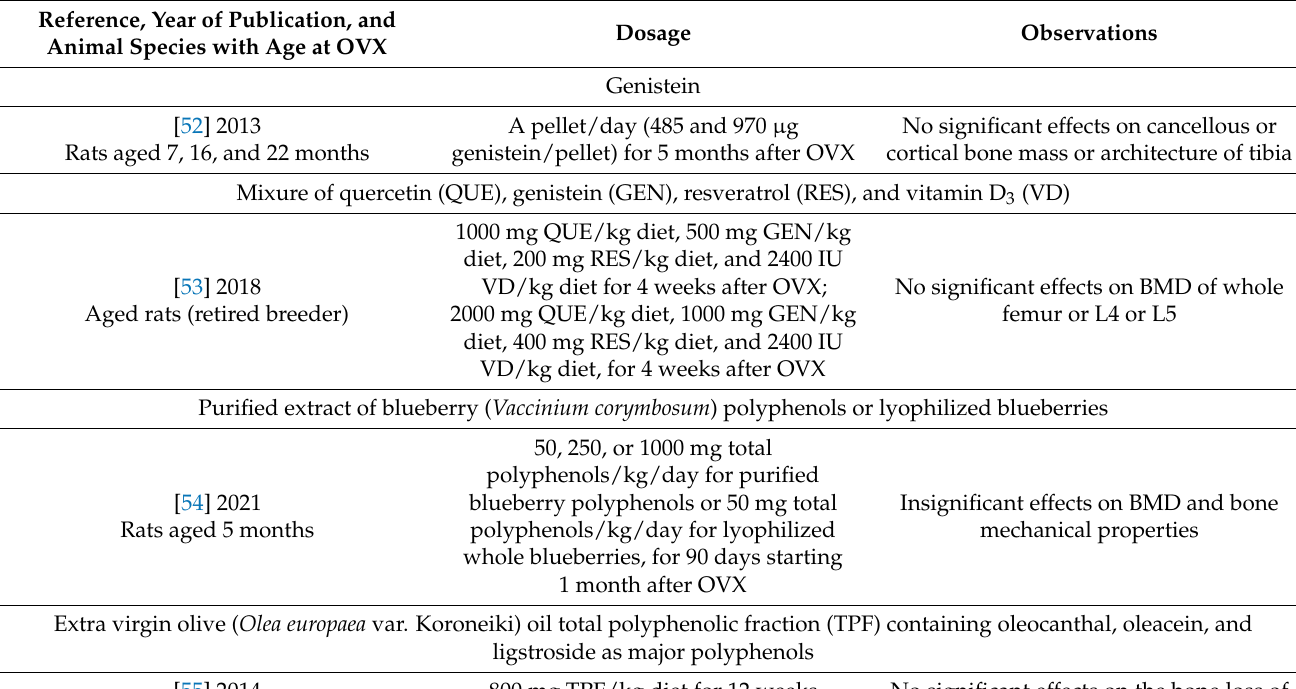
Table 4. Studies in which oral polyphenols and polyphenol-rich extracts did not show any beneficial effects on bone health in ovariectomized